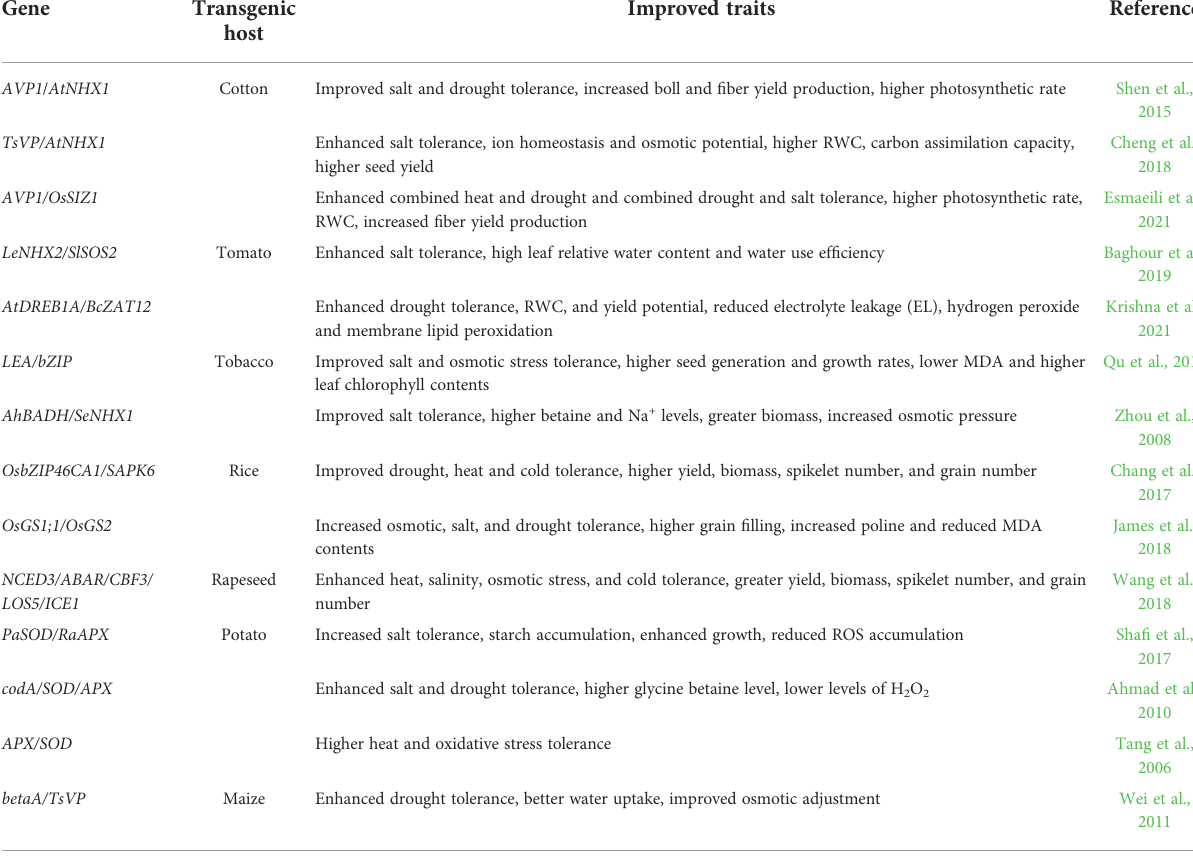
TABLE 4 Enhanced tolerance to multiple stresses using gene pyramiding